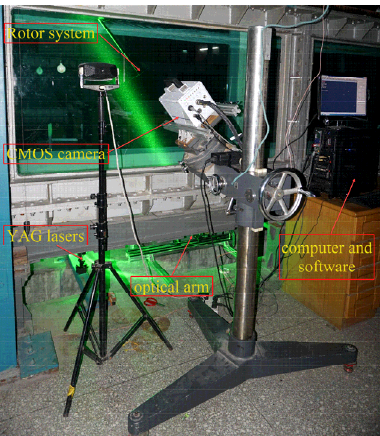
Figure 2. The experiment set-up.